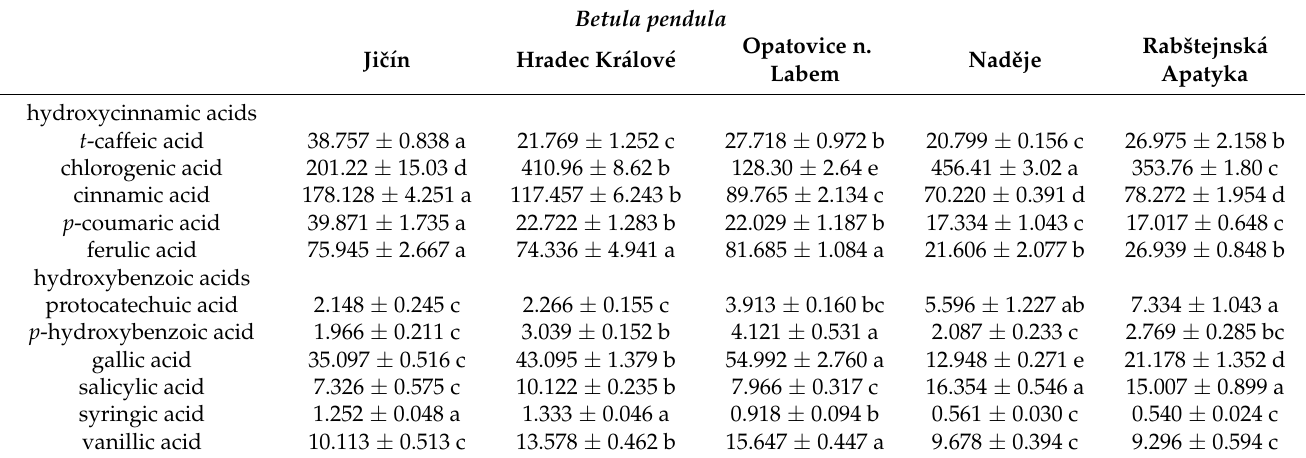
Table 4. The content of phenolic acids ( µ g g − 1 FW) in bud extracts of Betula pendula . Values are expressed as mean ± SDs ( n = 5). Different letters in lines show significant differences ( p < 0.05) according to Tukey’s